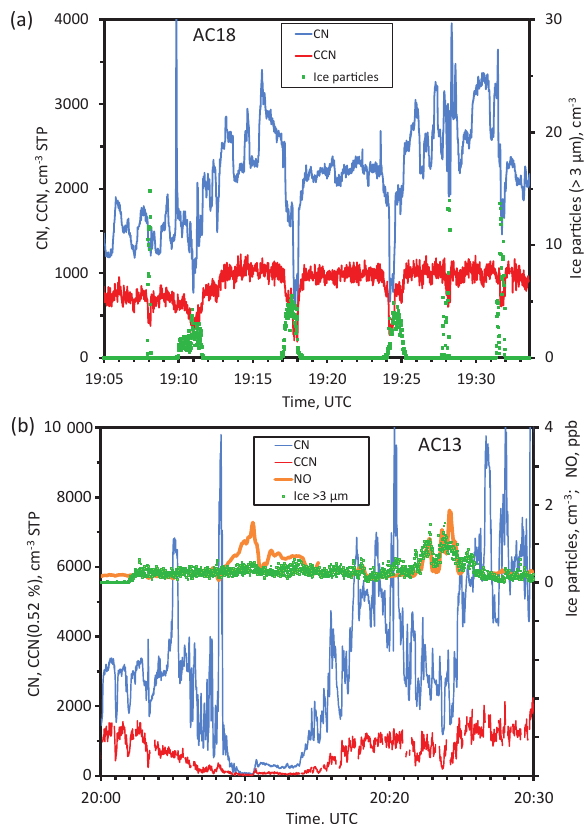
Figure 18. Measurements during passages through cumulonimbus cloud tops and outflow anvils: (a) several cloud top penetrations at 10.7 to 12km altitude on flight AC18 showing reduced N CN and N CCN0 . 5 inside the cloud top; (b) outflow from a large active cu- mulonimbus, showing strong aerosol depletion and NO production by